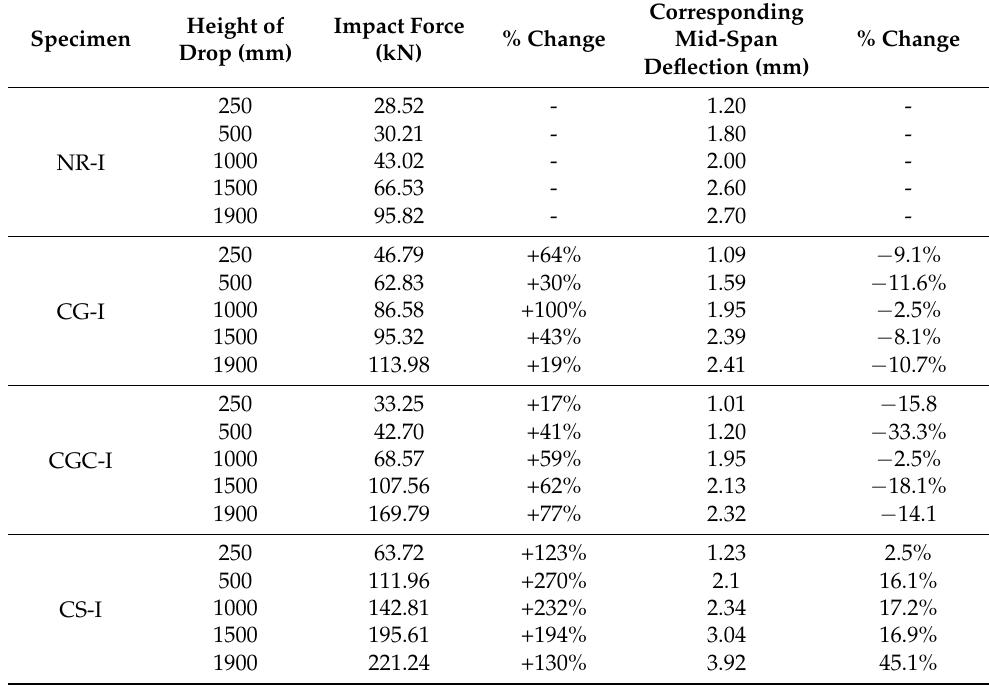
Table 6. Impact test